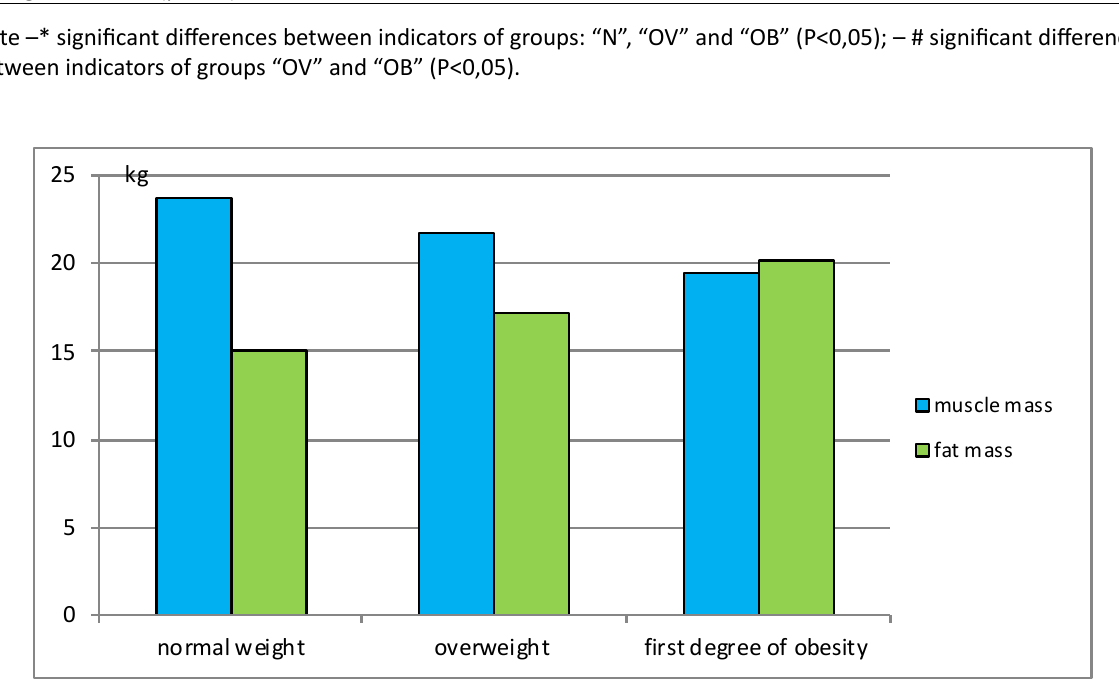
Fig. 3. Muscular and fat content of body (kg) of females with different